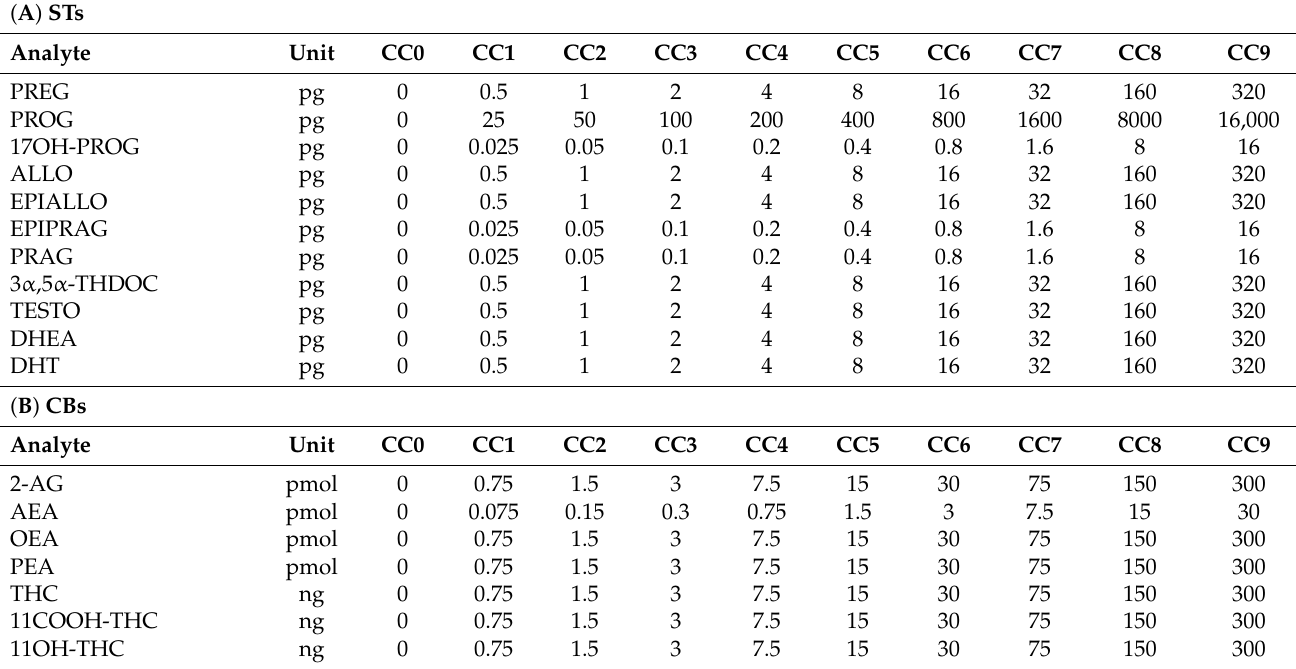
Table 3. Calibration curve levels (from CC0 to CC9) expressed as absolute amounts of